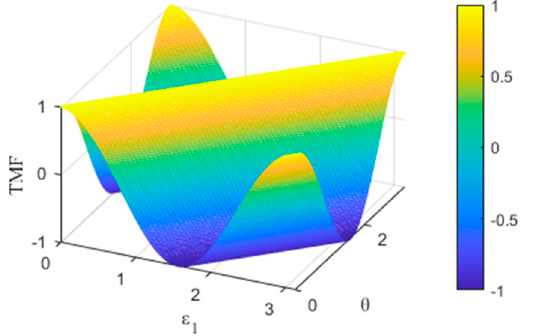
Figure 2. Numerical solution of TMF.